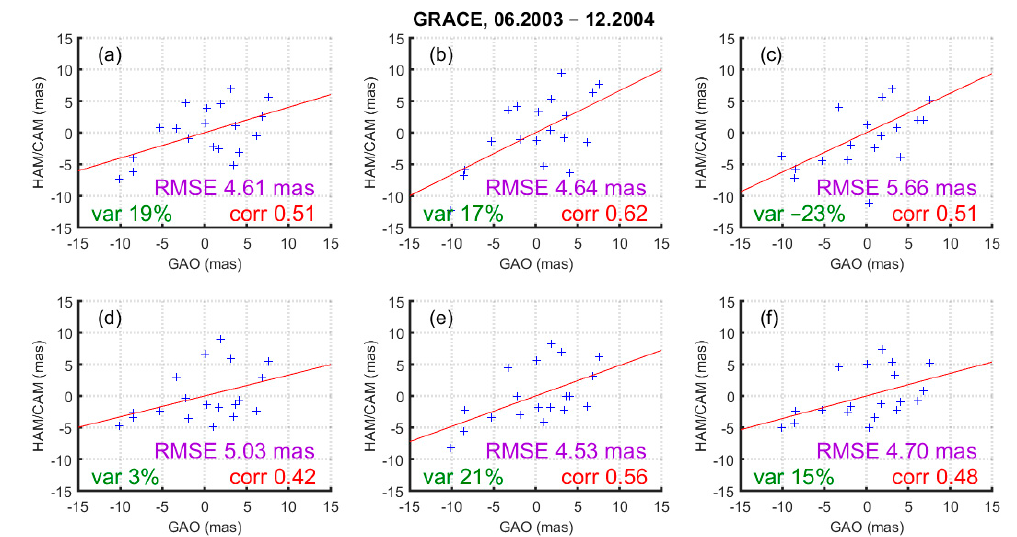
Figure 6. Scatter plots showing the relationship between the χ 1 component of GAO and HAM/CAM from ( a ) CSR GSM, ( b ) JPL GSM, ( c ) GFZ GSM, ( d ) CSR TWS, ( e ) JPL TWS, and ( f ) GFZ TWS. The red line was fitted to the data points using the least squares method. The values in purple indicate the RMSE, the values in red (corr) indicate the correlation coefficients between series, and the values in green (var) indicate the relative explained variances. The considered time period is June 2003 to December 2004. Note that the critical value of correlation coefficient for 12 independent points and a 95% confidence level is 0.50, while the standard error of the difference between two correlation coefficients is 0.47. All the parameters were computed after removal of trends.